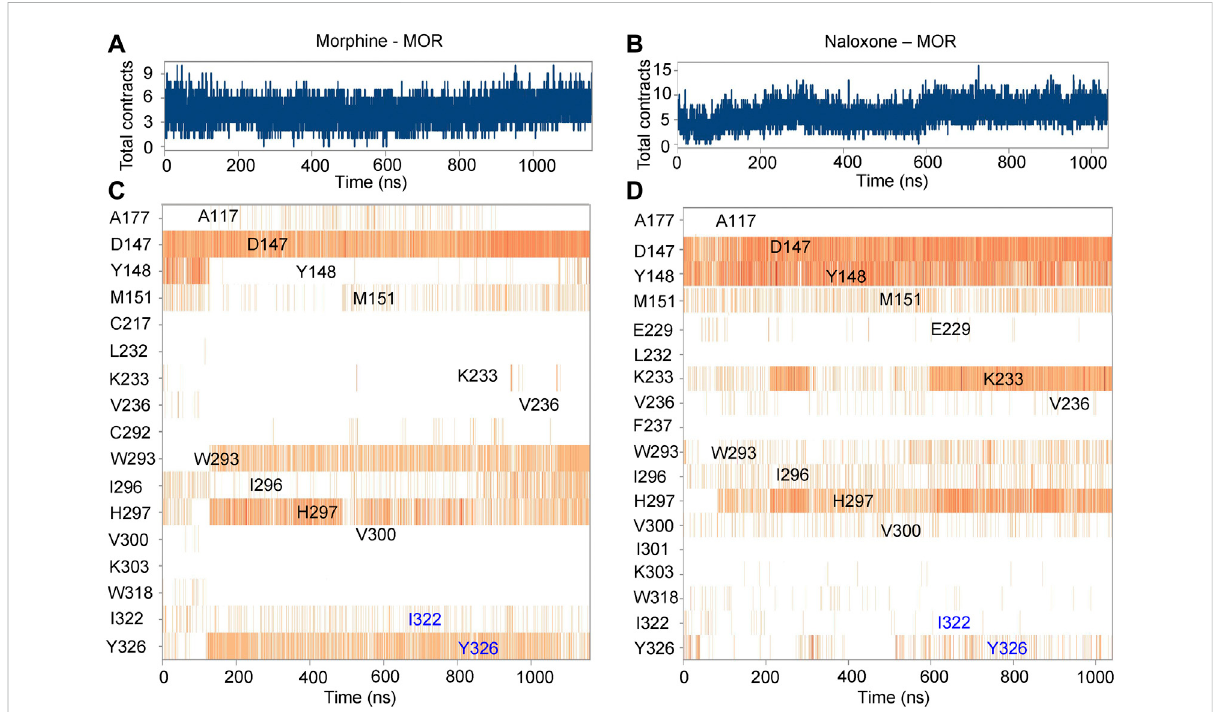
Timeline representation and summary of the interaction between morphine/naloxone and MOR. (A , B) , time-dependent interactions between MOR and morphine (A) or naloxone (B) throughout the MD simulations. The top panel represents the total contraction of MOR with the ligand throughoutthesimulation(onetrajectoryevery100pswithin0-1,000ns).Speci fi cresiduesinteractingwithmorphineornaloxonearehighlightedin blue.Thedarkerorangecolorindicatesthenumberofresiduesinteractingwiththeligand,assomeaminoacidshavemultiplespeci fi ccontracts with the ligand. (C , D) analysis and summary of the interaction of MOR with morphine (C) and naloxone (D) throughout the